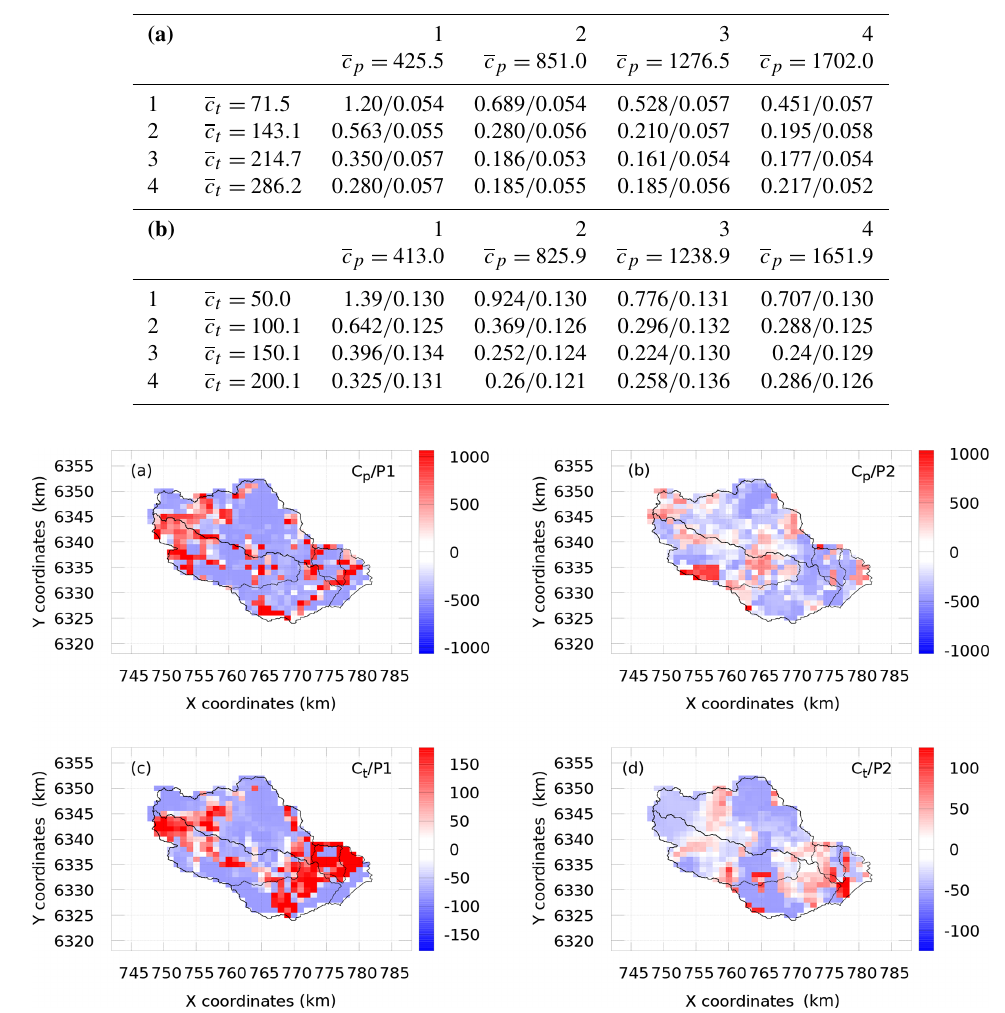
Table 6. Initial and final values (separated by a forward slash) of the cost function of Eq. (18) for different uniform priors for periods P 1 (a) and P 2 (b) for experiment 3.